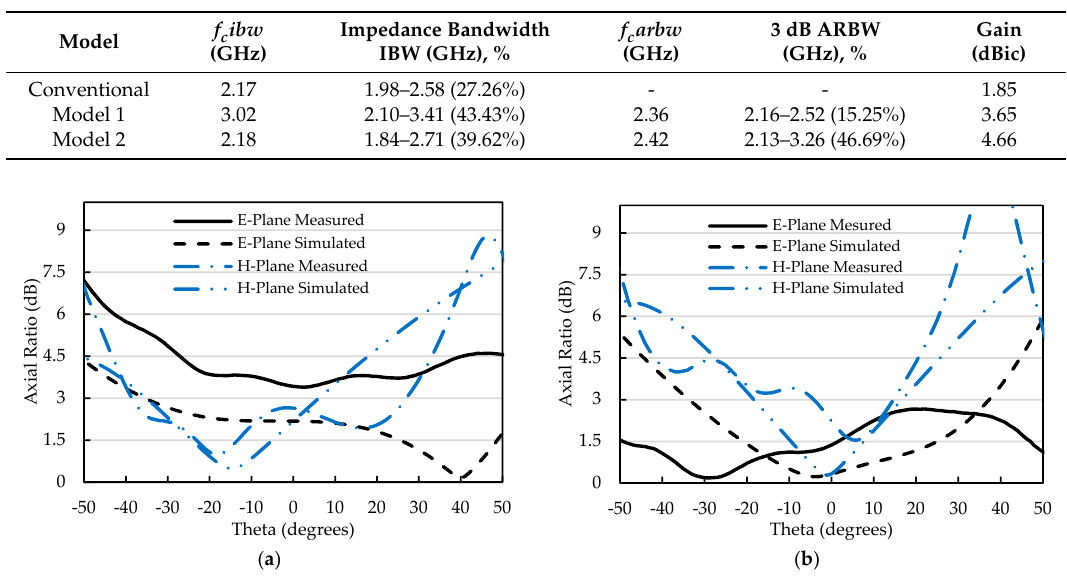
( b ) Figure 8. Fabricated antenna: ( a ) the antenna ground on the front side and ( b ) the feedline on the back side.